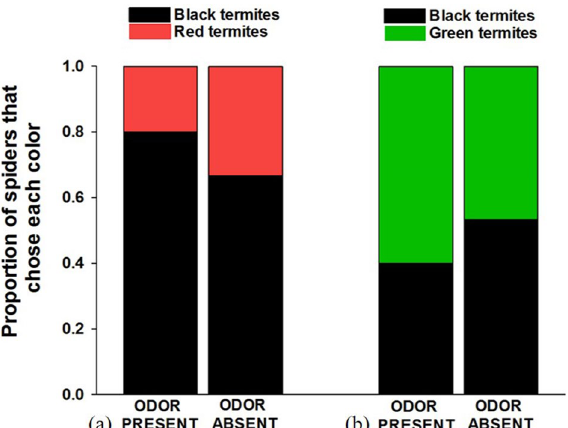
Figure 5. Results of choice tests between ( a ) red- and black-painted termites, and ( b ) green- and black- painted termites in the presence or absence of a defensive odor from the eastern lubber grasshopper ( Romalea microptera